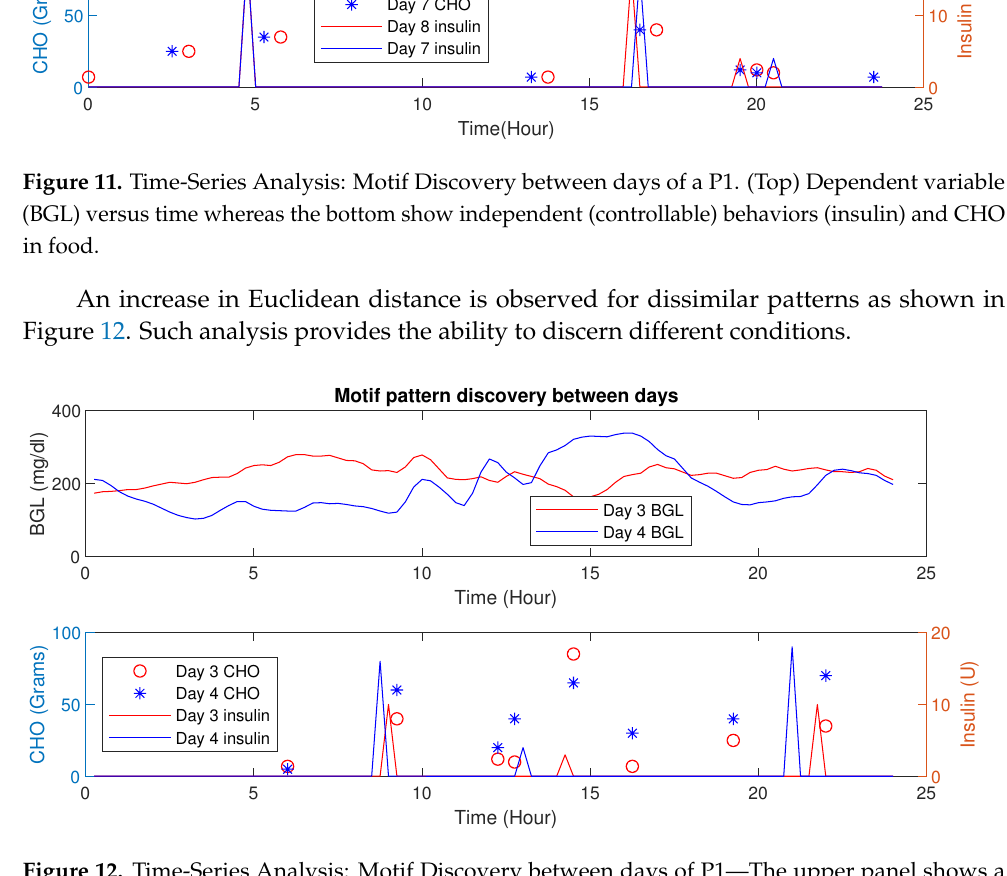
Figure 12. Time-Series Analysis: Motif Discovery between days of P1—The upper panel shows a dependent variable (BGL) versus time whereas the lower panel shows independent (controllable) behaviors (insulin) and the dependent variable